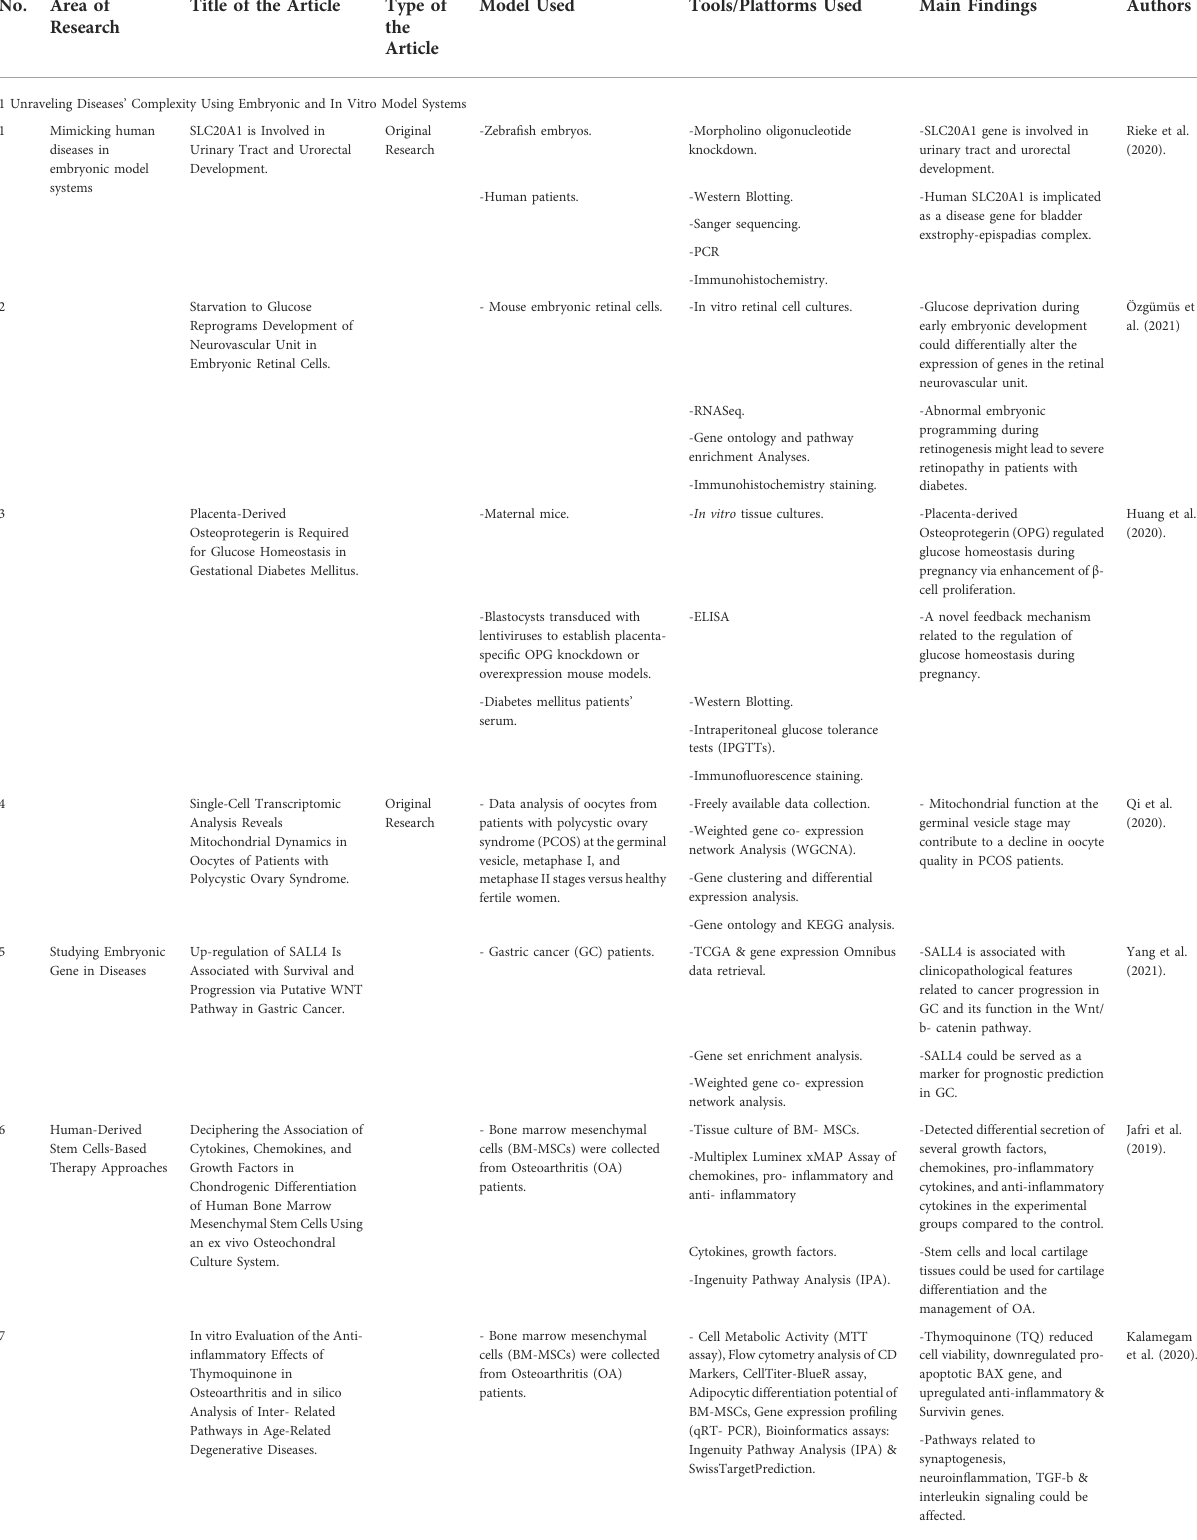
TABLE 1 A list of the accepted articles of the research topic summarizing the research area of each study, article ’ stitle,article ’ s type, the model used, tool/platform used, main fi ndings and the reference to each study. No. Area of